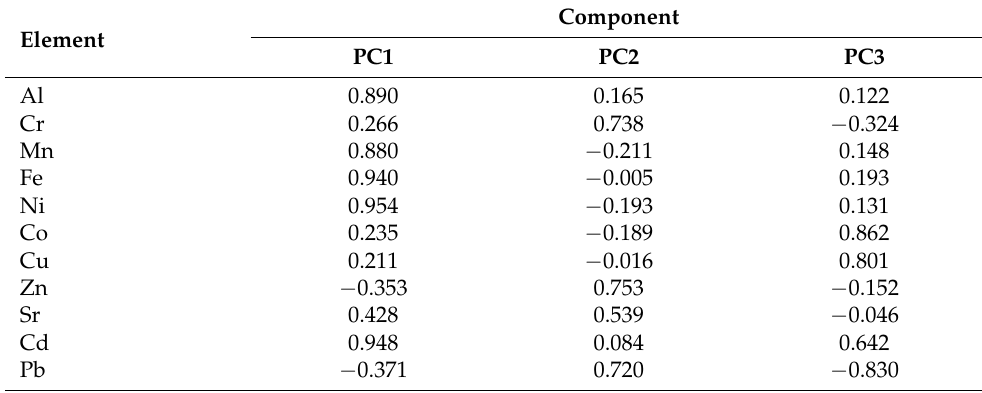
Table 13. Rotational component matrix (Varimax with Kaiser normalization) for experimental variables in the surface water samples (N =